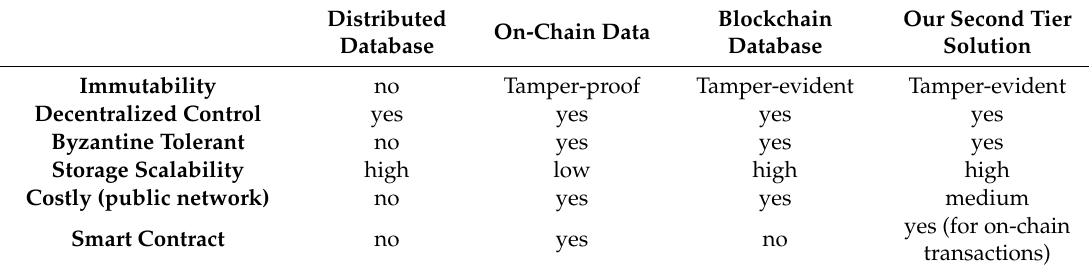
Table 1. State-of-the-art energy data storage